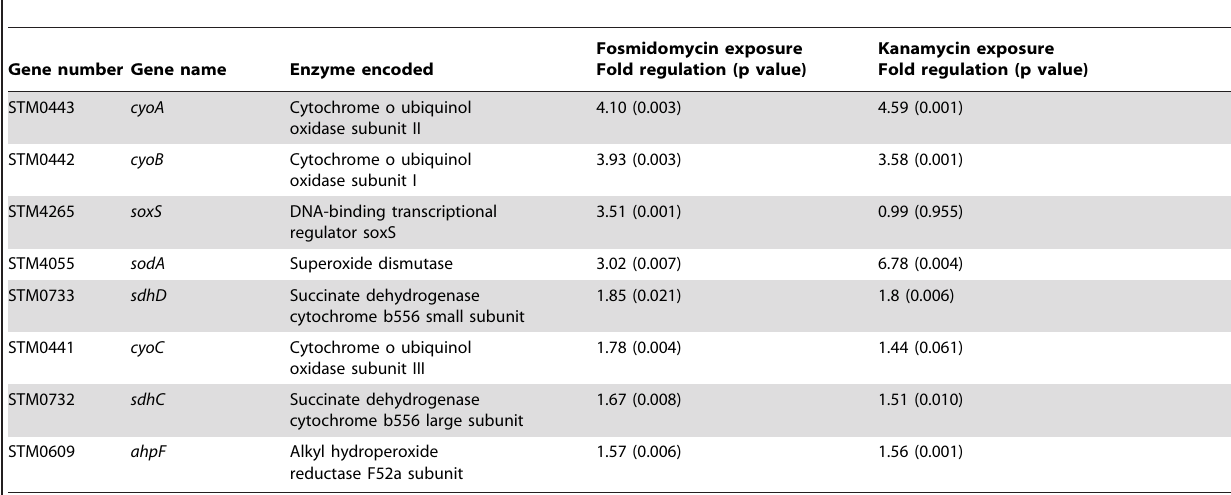
Table 2. Regulation of selected genes of relevance to oxidative stress identified in microarray analysis of short (20 min) sub- inhibitory exposures to fosmidomycin or